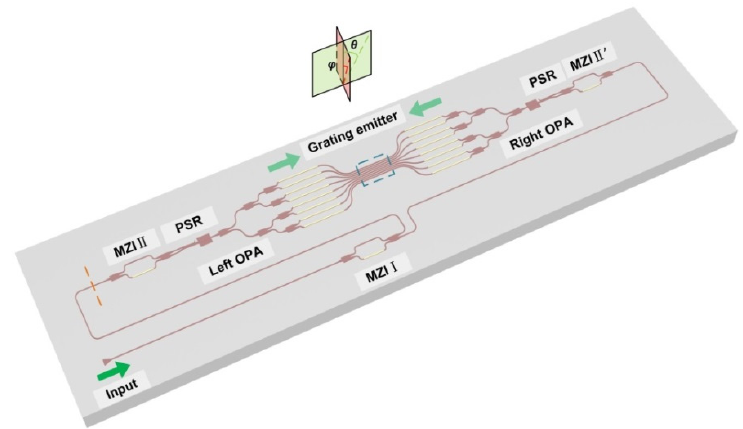
Figure 9. A schematic of the bi-directional dual polarization multiplexed OPA [85].